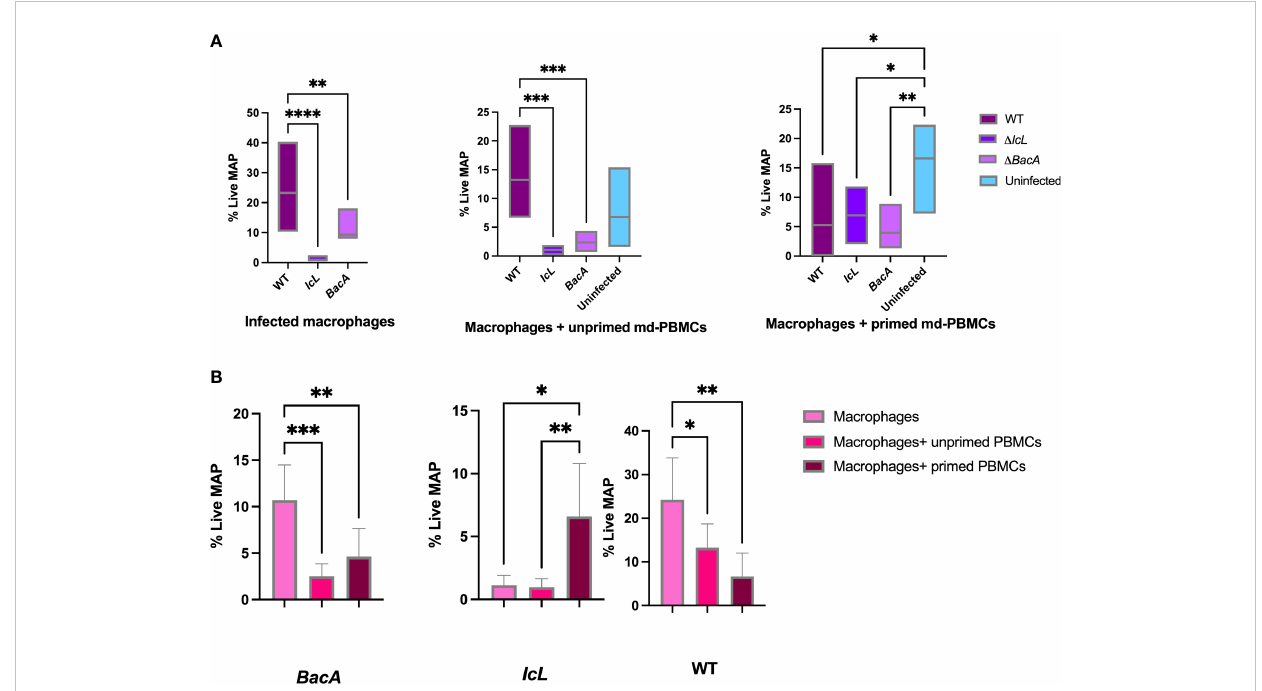
FIGURE 8 (A) MAP viability assay comparing percentage of live MAP in infected macrophages alone, infected macrophages incubated with unprimed md- PBMCs, and infected macrophages incubated with primed md-PBMCs. (B) Viability assay comparing different treatments within groups. The difference among groups were assessed by one-way ANOVA and then further validated by Tukey-Kramer test. * P ≤ 0.05; ** P ≤ 0.01; *** P ≤